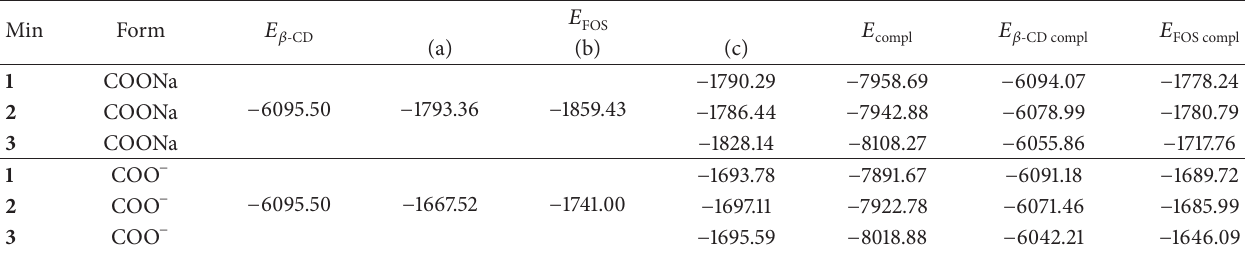
Table 1: Heats of formation, kJ/mol, calculated with the PM3 method for the geometry optimized free host ( 𝐸 𝛽 ), respectively, and also the single point energy values for the host structure ( 𝐸 𝛽 complex ( 𝐸 compl respectively, taken from the optimized complex geometry for the two possible forms (salt and ionic) of fosinopril and the three conformations taken to account for free FOS: (a) the nearest stable conformation to the crystal structure; (b) the global minimum energy conformation; (c) the nearest stable conformation to the FOS geometry in the complex; 1 , 2 , and 3 correspond to the three energy minima obtained by MM+